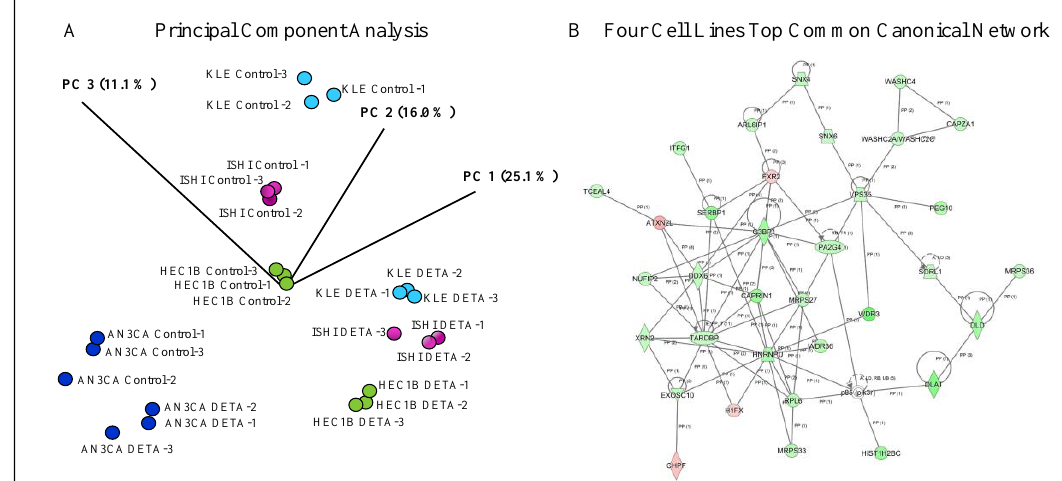
Figure 6. Comparison of overall expression profiles across all samples. ( A ) Results of the principal component analyses (PCA) of gene expressions in DETA / NO and vehicle-treated cancer cells are shown. Each color represents one cell line (both vehicle-treated control and DETA / NO-treated samples were the same color). Blue: AN3CA, Turquoise: KLE, Magenta: Ishikawa, Green: HEC-1B. The PCA plot shows each DETA / NO-treated cell line forms its own cluster and is clearly separated from its matching control sample clusters. ( B ) Ingenuity Pathway Analysis (IPA). The top and common canonical networks identified among fours cell lines (AN3CA, KLE, Ishikawa, and HEC-1B). The pink color indicates upregulation and a light green color indicates downregulation of that particular gene. Table 2. Top three canonical pathways identified in each cell line. Cell Lines